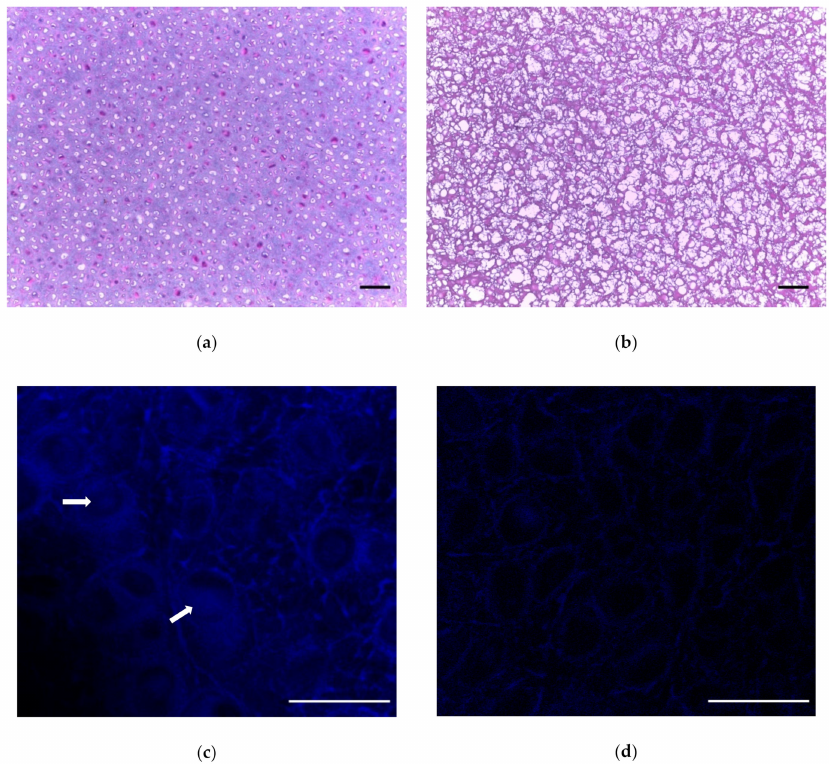
Figure 3. Visualization of cartilage tissue by histology. ( a ) Nondecellularized porcine cartilage stained with H&E, 10 × transverse image. ( b ) H&E stain on final decellularized cartilage, transverse image. ( c ) Hoechst stain to fluorescently visualize DNA (blue). Arrows indicate nuclei. ( d ) Hoechst stain shows absence of DNA after decellularization process (see absence of blue). Scale bar = 100 µ m for ( a , b ); scale bar = 50 µ m for ( c , d ).